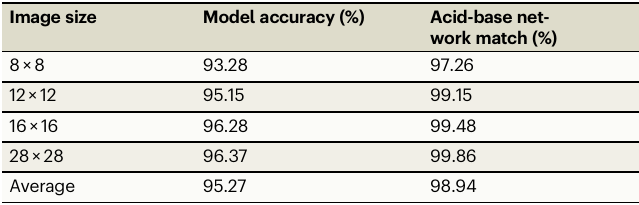
Table 3 | Matching accuracy for 2-class, 3-bit image classi fi er Image size Model accuracy (%)